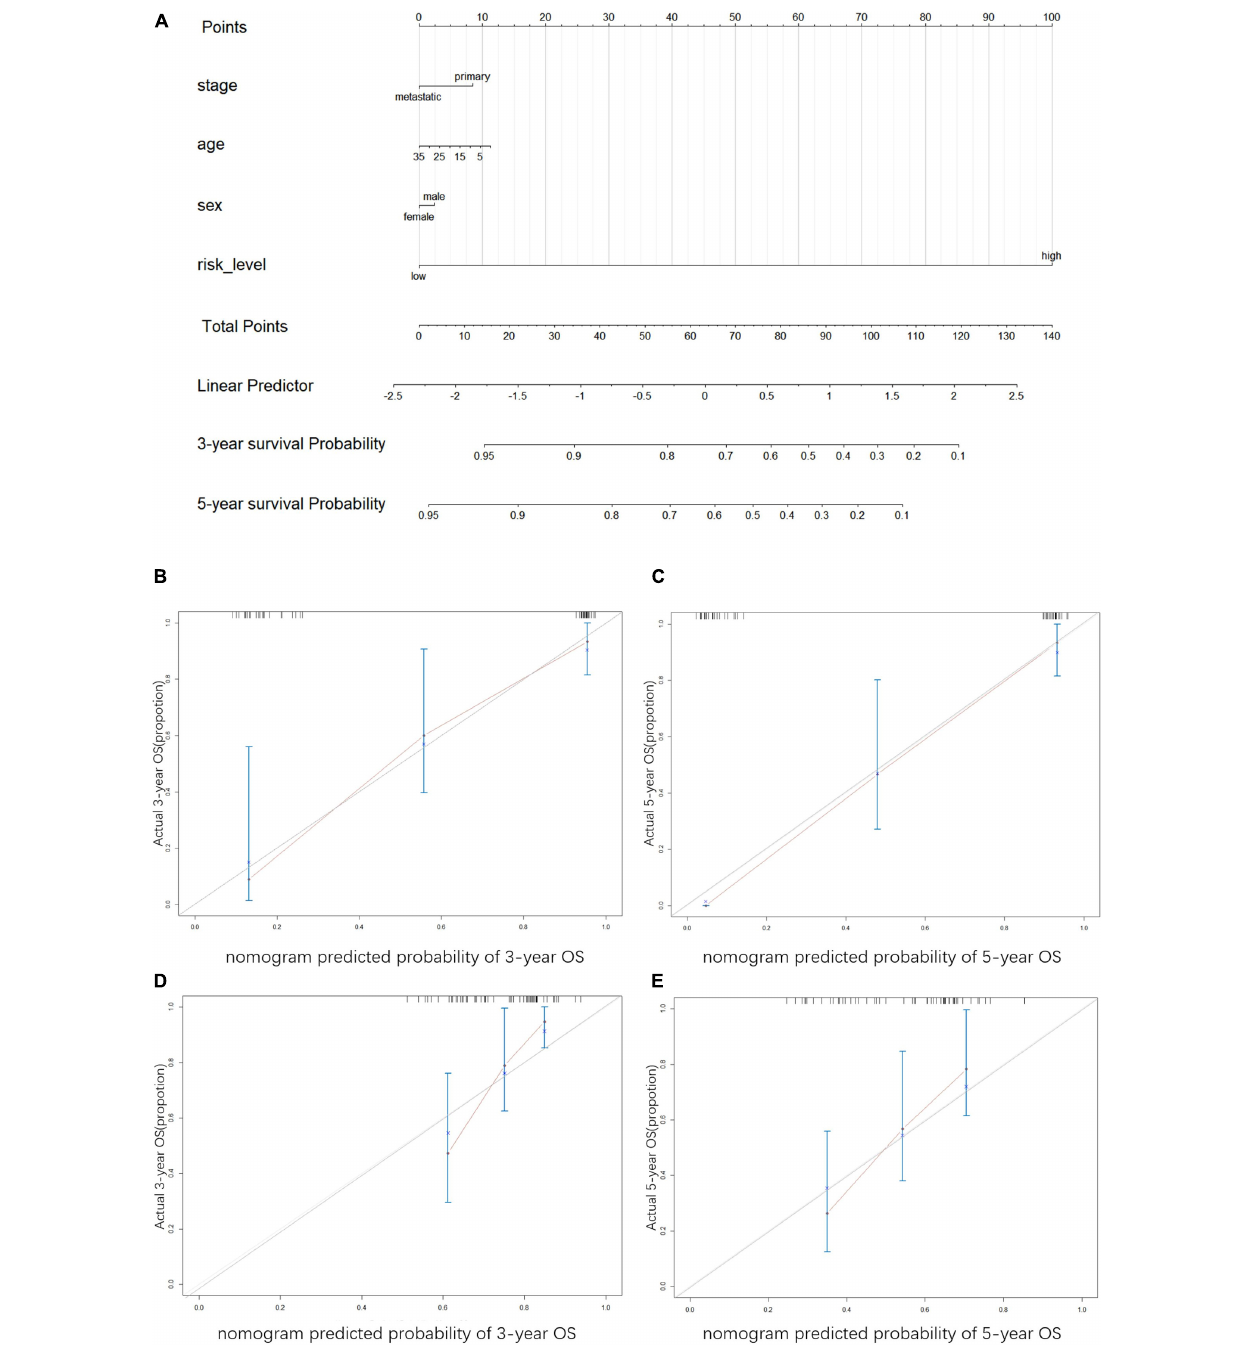
FIGURE 9 | Construction and verification of nomogram (A) Nomogram was constructed to predict the survival time. The risk level, age, gender, and metastasis status were used as variables. 1. Names of the variables in the prediction model: for example, age, gender, stage, and risk level. Each variable corresponds to a line segment marked with a scale, representing the range of values that can be taken for that variable, while the length of the line segment reflects the size of the contribution of that factor to the outcome event. 2. Scores, including individual scores; “Points” in the figure, which represent the individual scores corresponding to each variable at different values; and total scores. “Total Points”, which represents the total scores of the individual scores corresponding to all variables taken together. 3. Predicted probability: the 3- and 5-year survival probability in the figure. The graphs show the calibration plots for internal validation of (B) actual 3-year OS and (C) 5-year OS; and for extral verfication of (D) actual 3-year OS and (E) actual 5-year OS. The vertical coordinate represents the actual overall survival while the horizontal coordinate represents the predicted overall survival, the red line is the fitted line, which indicates the actual value corresponding to the predicted value, small ticks at the top of each plot representative ES patients, and the three vertical lines connected by the red lines represents the estimated fluctuation of each point.